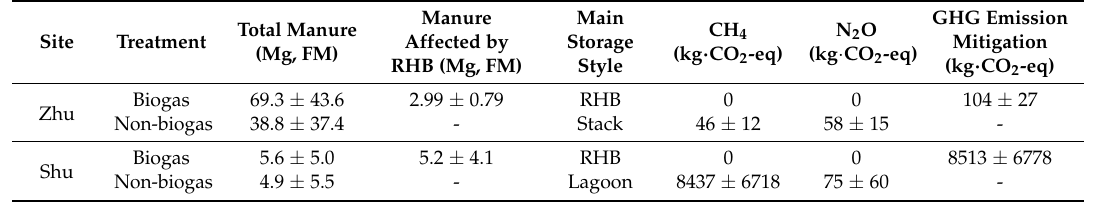
Table 3. GHG reduction from manure input for biogas over a 12-month period, per household.